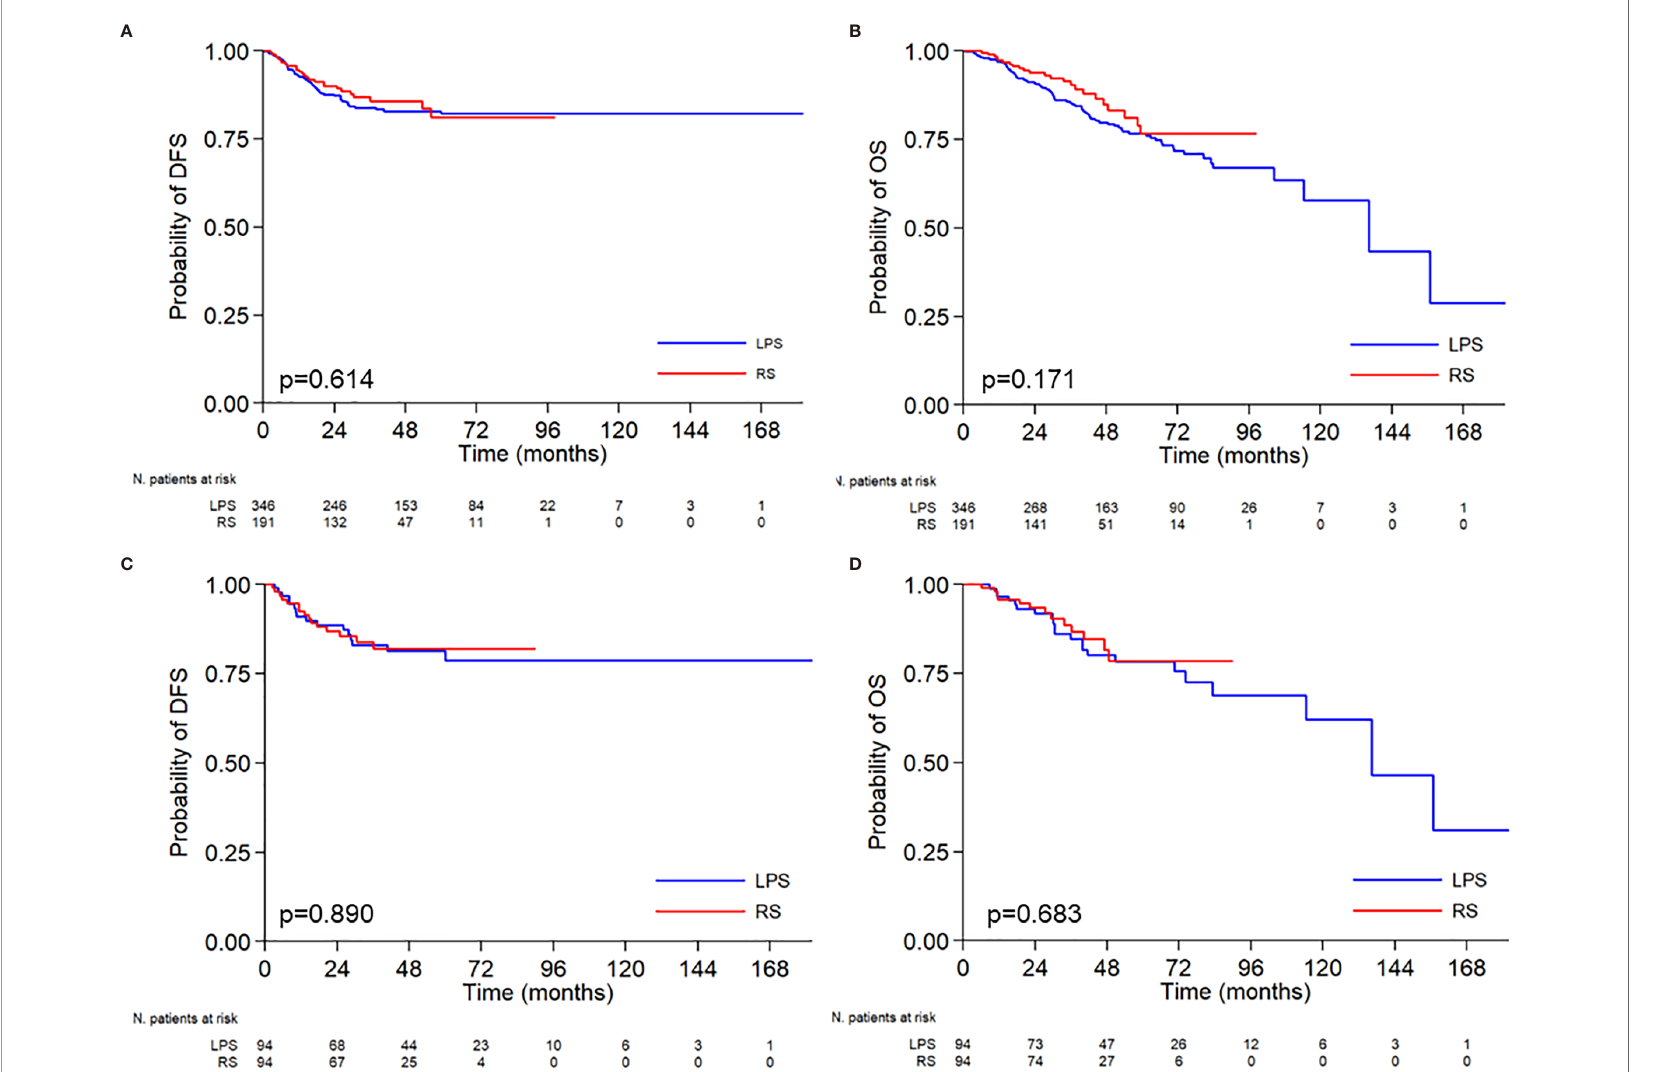
FIGURE 1 | Kaplan-Meier curves relative to disease free survival-DFS (A – C) , and overall survival-OS (B – D) according to the surgical approach. Median DFS: not reached vs not reached. Probability of DFS at 5 years 78.8% vs 81.9%. Median OS: 136.2 months vs not reached. Probability of OS at 5 years 78.2% vs